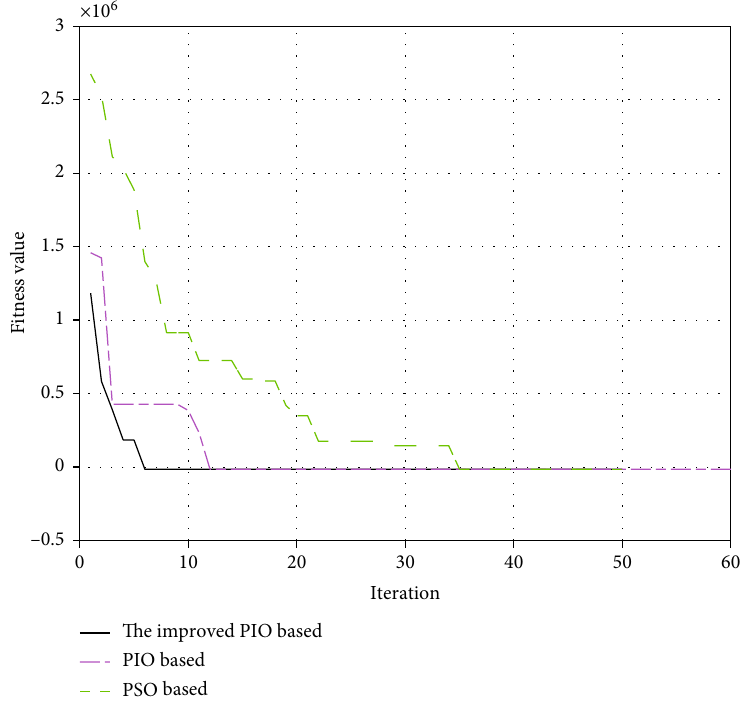
Figure 7: Fitness value versus iteration